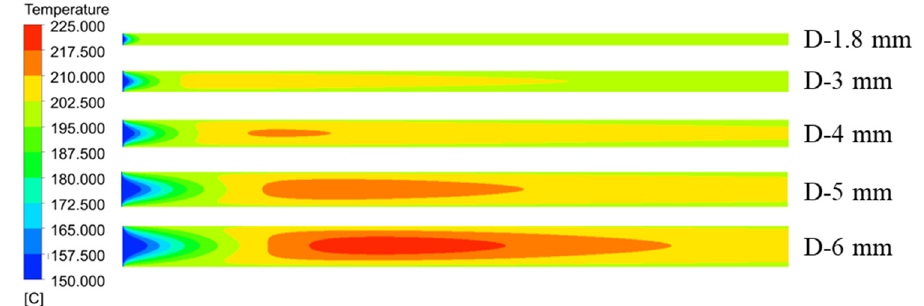
Figure 17. Temperature distribution cloud diagram of the axial section of the microreactor at different tube diameters.